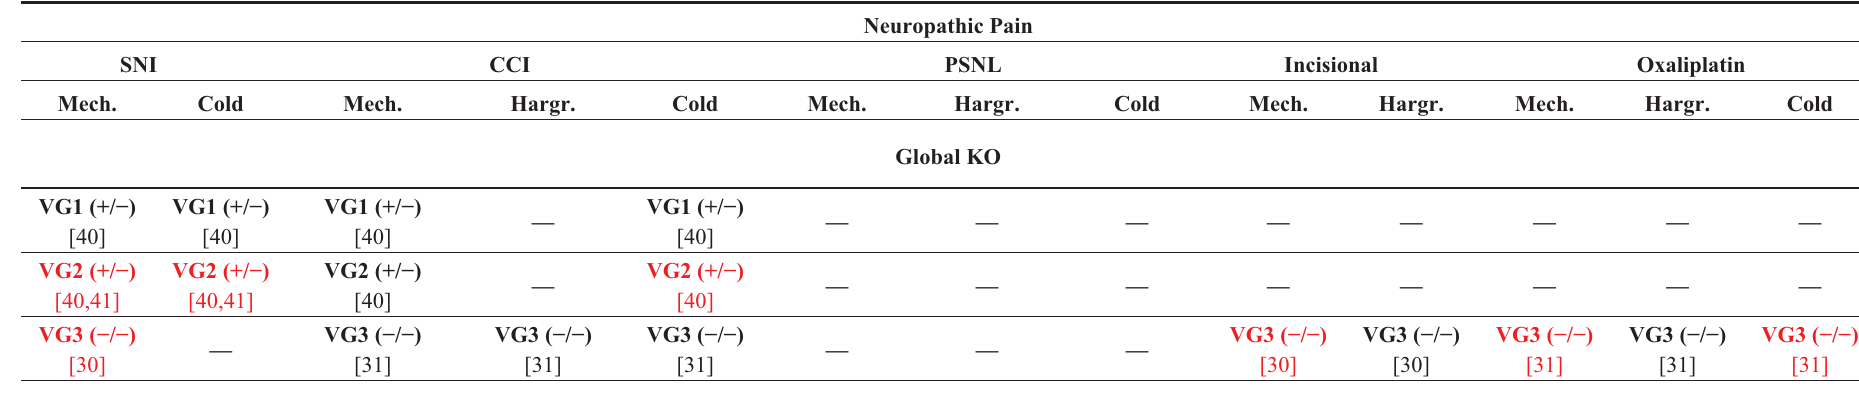
Table 4. Effects on nociceptive pain and itch of various types of VGLUT deletion (Reductions are shown in red, lack of change are shown in black and dashes show pain modalities that have not been assessed). SNI CCI PSNL Incisional Oxaliplatin